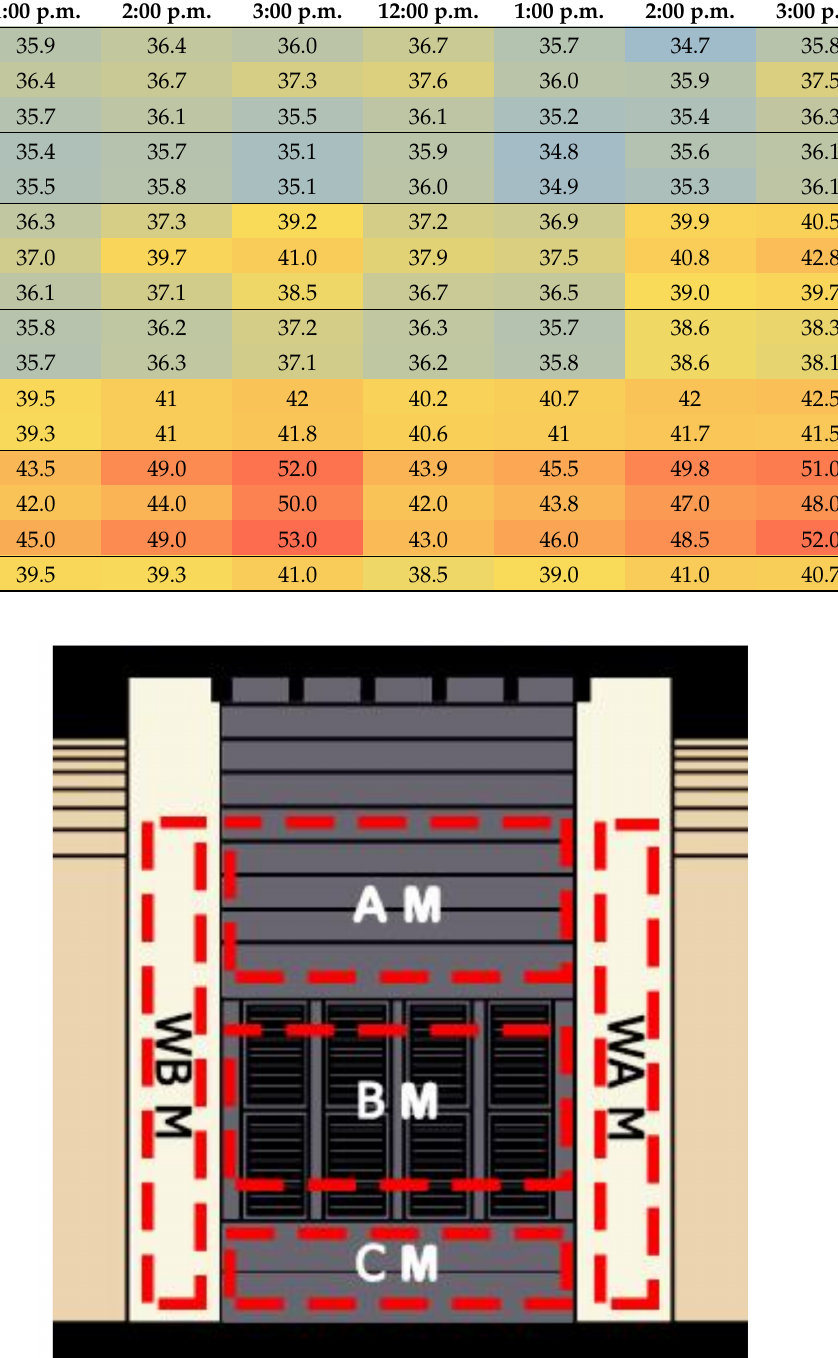
Table 12. Surface temperatures of Room 1, Room 2, and the courtyard on 26 August and 1 September 2018.